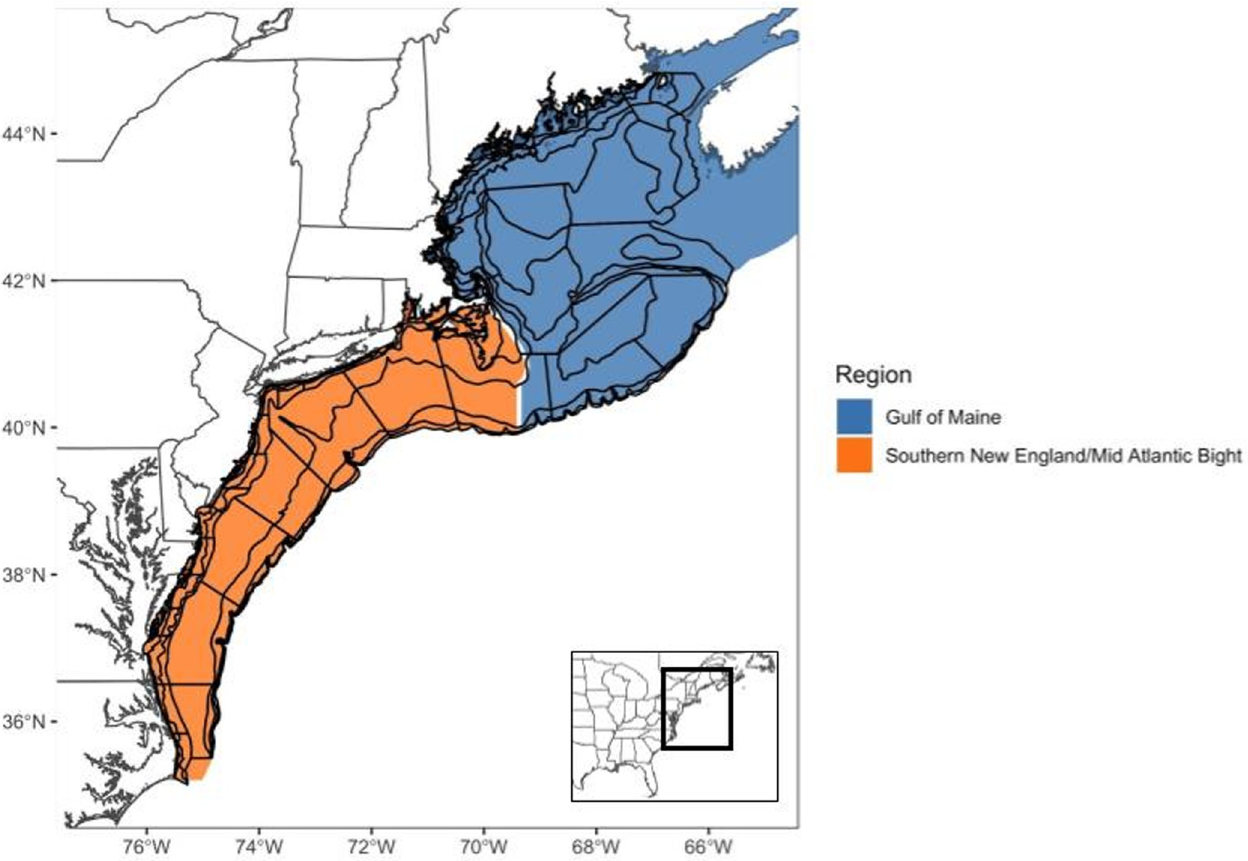
Fig 1. The Northeast Shelf Large Marine Ecosystem study area [53]. Polygons within the Northeast Shelf Large Marine Ecosystem designate the habitat strata used to create a stratified random bottom trawl survey, conducted by the NOAA Northeast Fisheries Science Center. Within the Northeast Shelf Large Marine Ecosystem, there are two relatively distinct biogeographic regions: the Gulf of Maine (blue shaded habitat strata polygons) and the southern New England/Mid Atlantic Bight (orange shaded habitat strata polygons).